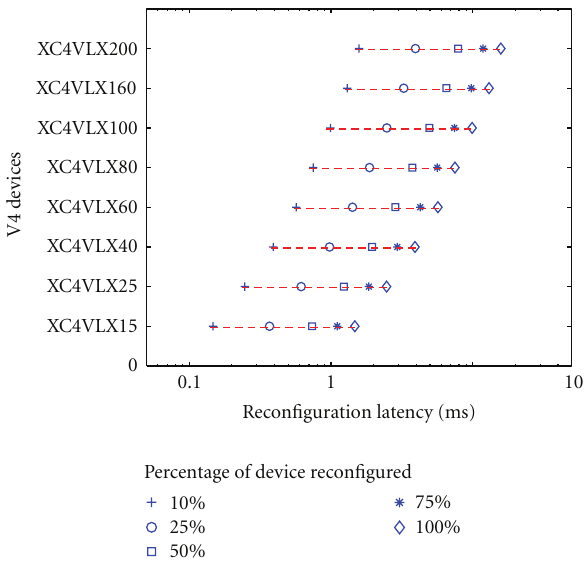
Figure 2: Virtex 4 family partial reconfiguration times. Points were calculated using the bitstream sizes reported in the device’s datasheets and a theoretical maximum reconfigurable speed of 3.2Gbits/sec